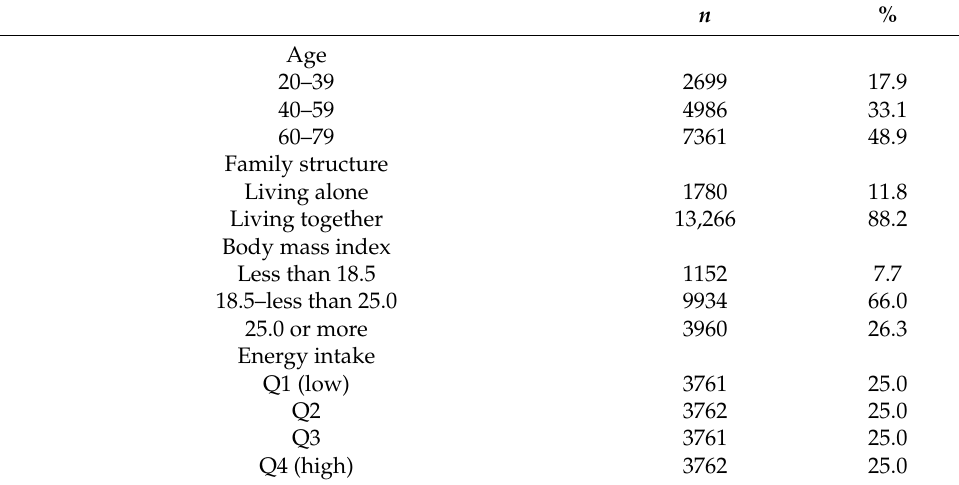
Table 2. Distribution of